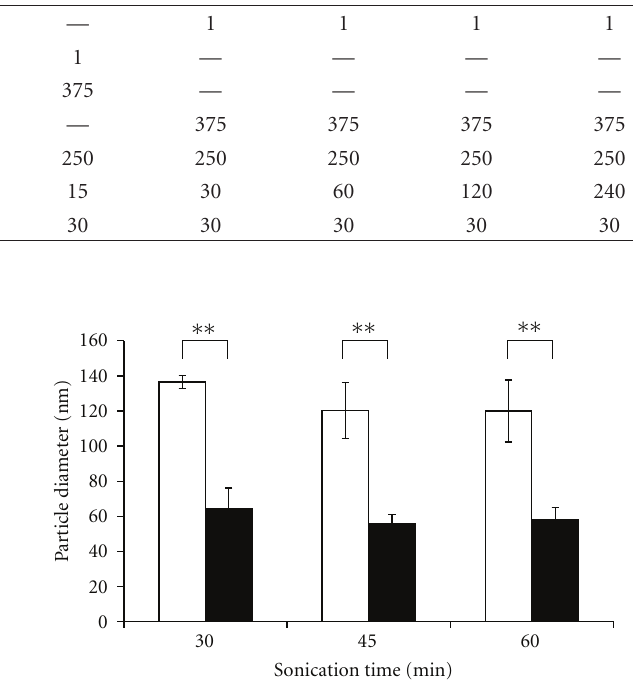
Figure 2: E ff ect of co-surfactants and sonication time on the particle diameter of curcumin-loaded lipid nanoemulsions. Closed bar: Tween 80, formulation 1. Open bar: HCO-60, formulation 2. Data are represented as the mean ± standard deviation of 3 independent experiments ( n = 3). ∗∗ Significantly di ff erent from the HCO-60 formulation ( P < 0 . 01) by one-way